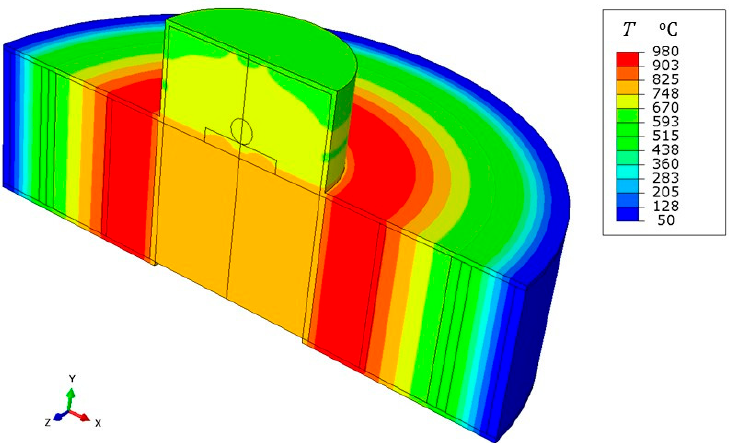
Figure 13. Steady state temperature field provided by an axisymmetric finite element model of the same radial strip utilized for the resistance network. Adiabatic conditions were considered at the top and at the bottom for the coaxial layers, whilst the drop melting temperature was prescribed over the test chamber walls. Three dimensional rendering was applied.